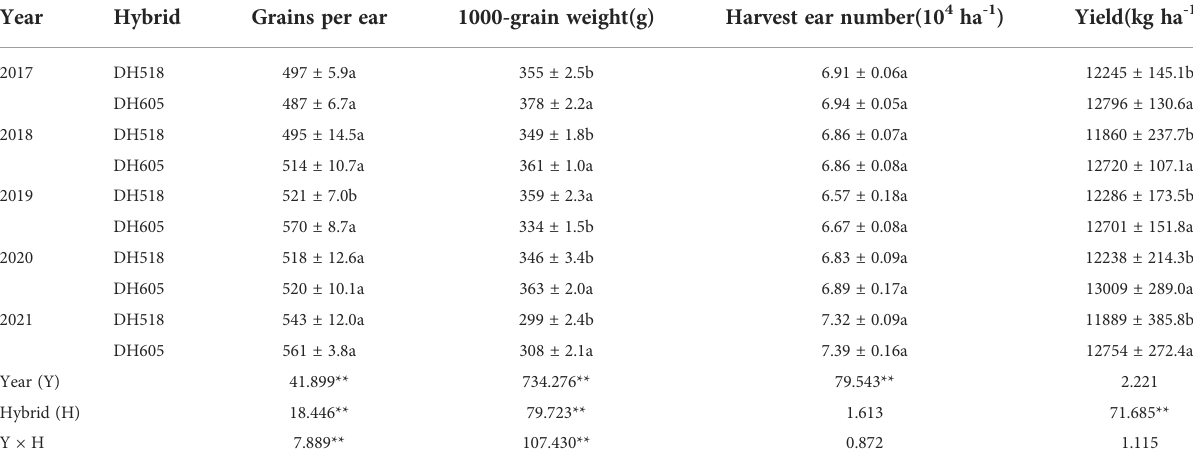
TABLE 1 Grain yield and yield components of summer maize hybrids with different growth duration from 2017 to 2021.